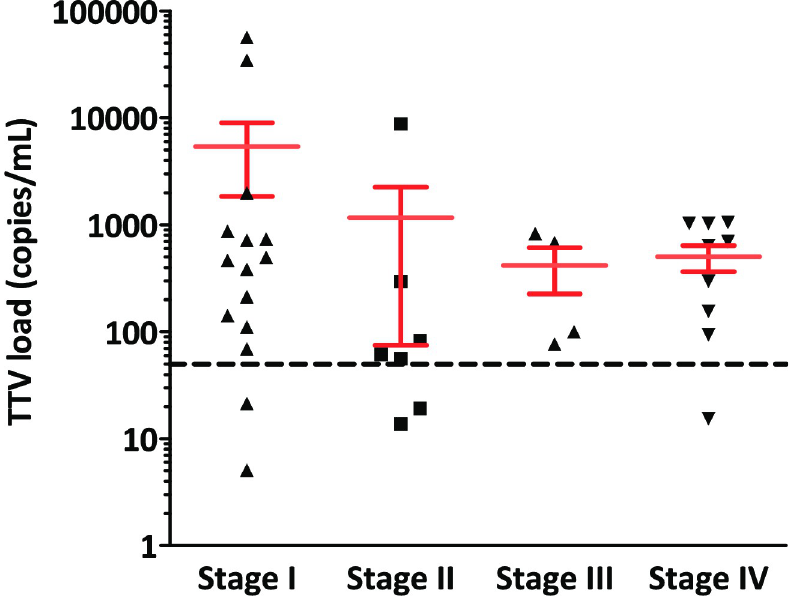
Fig 2. TTV DNA levels in the lung cancer patients grouped by TNM stage (UICC 8th edition). There was no significant difference in the 4 stage groups (p = 0.436).